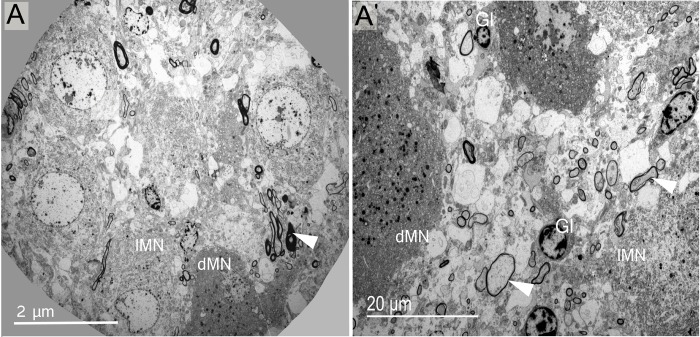
Fine structure of magnocellular neurones.(A, A') Electron microscopic observations of the dromedary SON revealed the presence of two distinct MN phenotypes—light (lMN) and dark (dMN). Light profiles are more abundant than dark. Other important elements found in the SON are myelinated axons (arrowheads). Glial cells (Gl) are observed in different levels of the HNS, and parenchymal glial cells are seen (A').